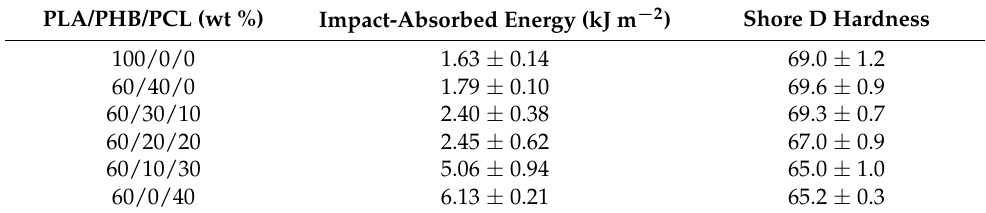
Table 2. Mechanical properties (Charpy impact test on notched samples and Shore D hardness)